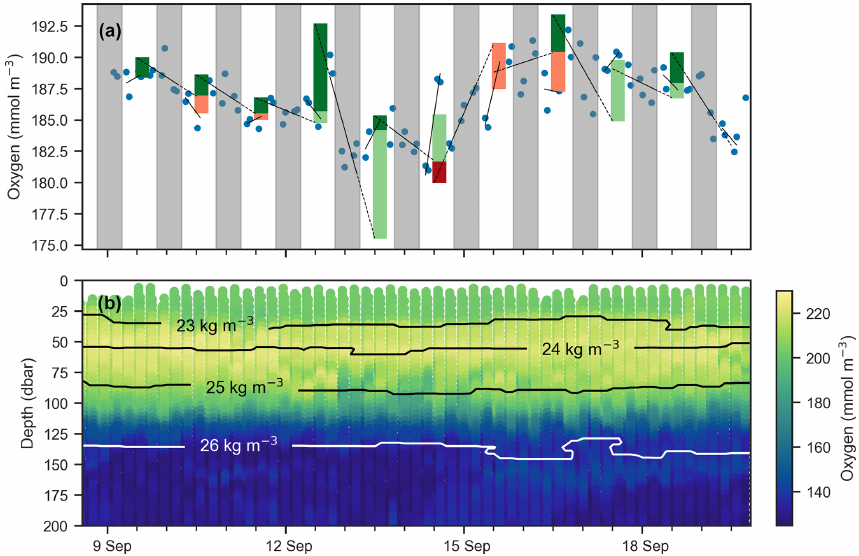
Figure 6. (a) Mean oxygen in the euphotic zone for continuous-mode measurements in September from float f8081, with attempts to estimate GPP. The legend is the same as Fig. 5, but orange and red bars indicate when the method obviously fails because other processes than production and respiration are driving changes in oxygen. Gray shaded sections show local nighttime. (b) Oxygen data over the same period with overlaid isopycnal